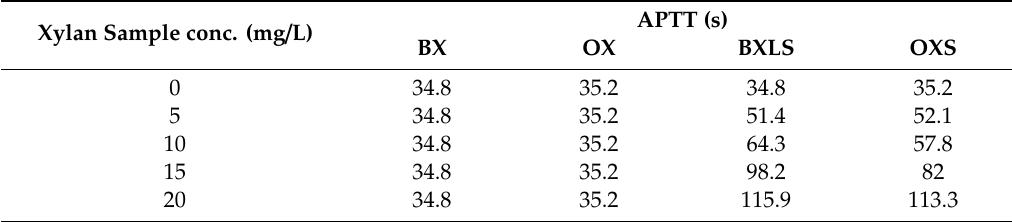
Table 2. Activated partial thromboplastine time for di ff erent concentrations of non-modified (BXL, OX) and sulfated xylan samples (BXLS, OXS). Xylan Sample conc. (mg /